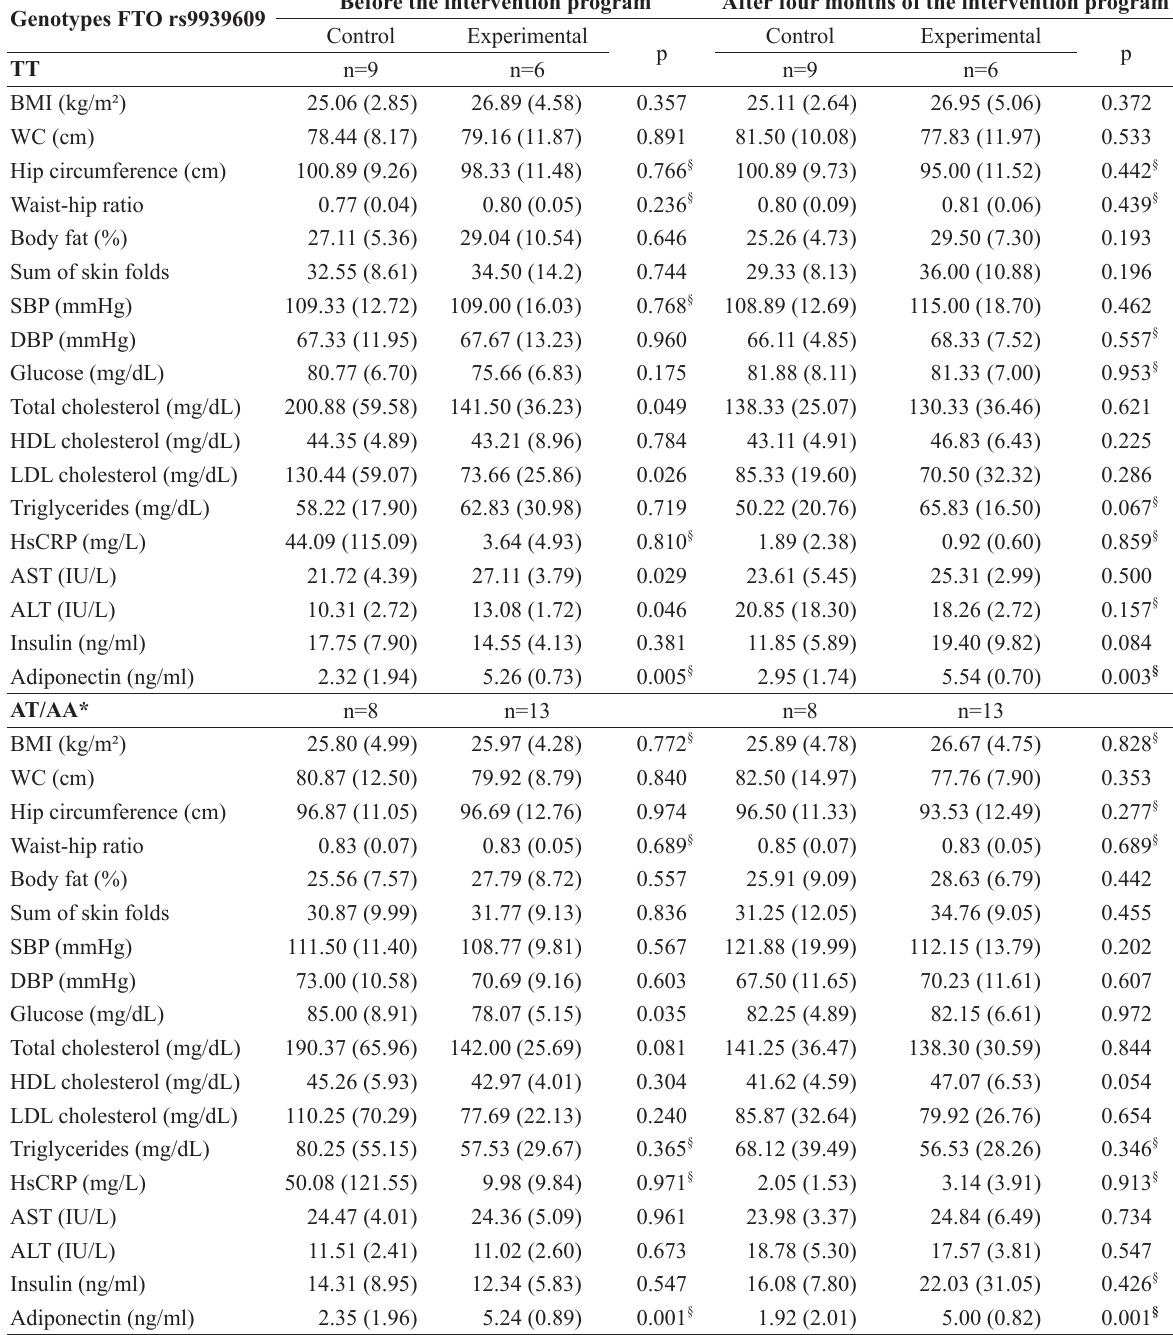
Control versus experimental group comparison of biochemical and anthropometric variables before and after 4 months of the intervention